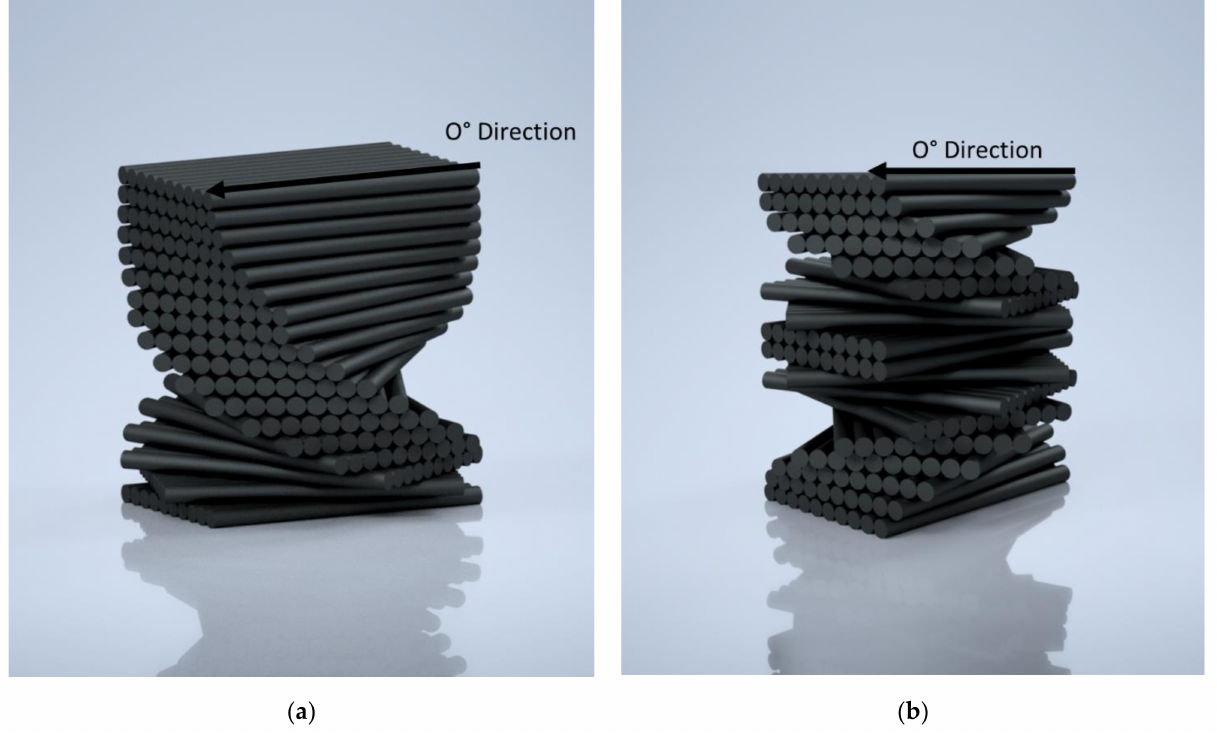
Figure 3. Layout of the designed helicoidal structures: ( a ) asymmetric (FGPA) and ( b ) symmetric (FGPS).